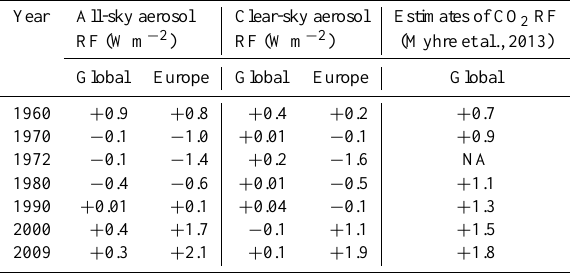
Table 6. Global and European shortwave top of atmosphere all-sky and clear-sky aerosol RF, relative to a 1980–2000 mean. Values for 1972 are included as this is when the simulated minimum aerosol RF occurs over Europe. For comparison we include global carbon dioxide RF (relative to 1750) from the IPCC fifth assessment report (Myhre et al.,